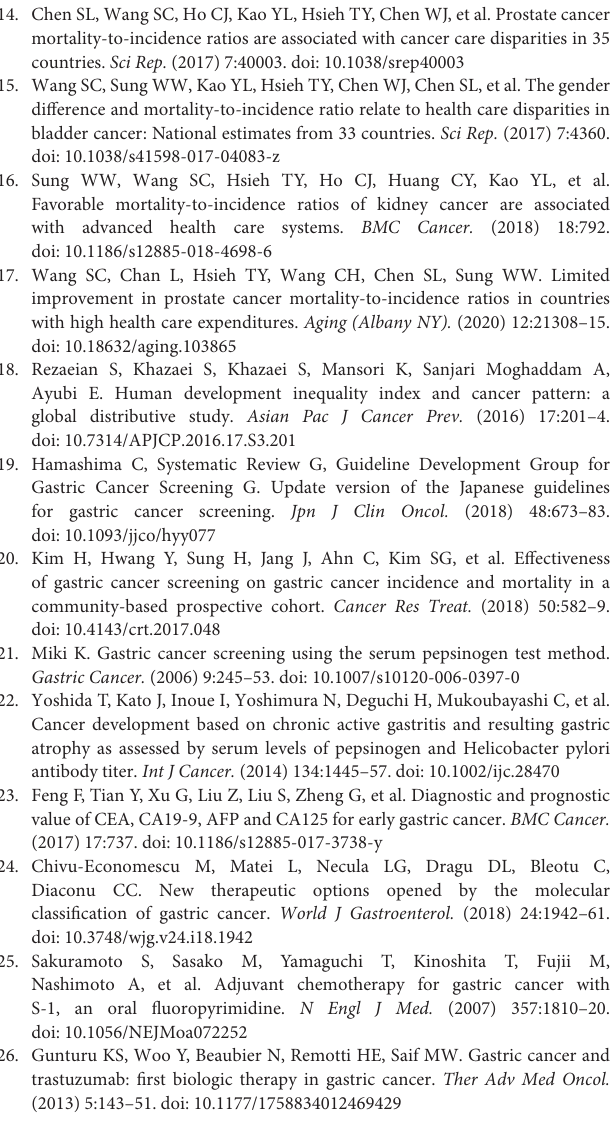
Supplementary Figure 1 | Association between human development index, current health expenditure and the crude rates of (A,C,E) incidence, and (B,D,F) mortality in gastric cancer. Supplementary Figure 2 | The (A) human development index, (B) current health expenditure per capita, and (C) current health expenditure as a percentage of gross domestic product are not significantly associated with delta mortality-to-incidence ratio in gastric